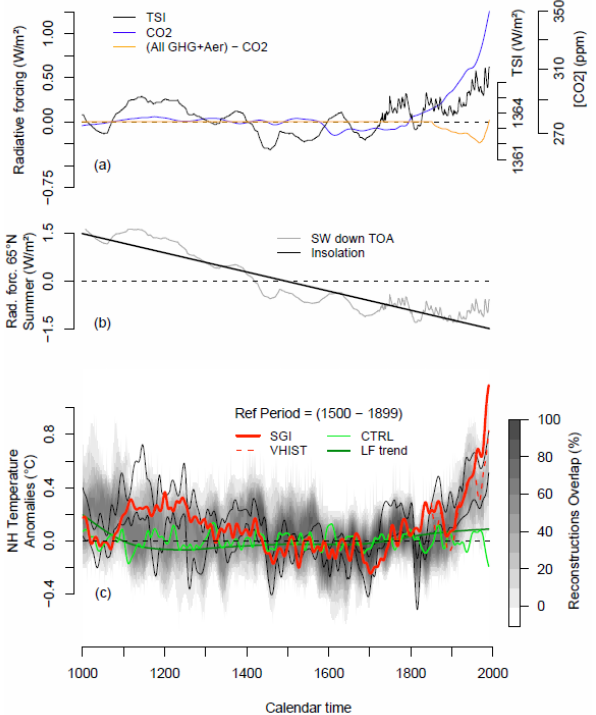
Figure 2 : Comparisons between thee recent reconstructions of the Northern Hemisphere surface temperature with SGI (red lines), on the 1000-1850 AD period. The upper panel (a) shows the reconstruction provided by (Mann et al., 2008) (blue lines), using both land and ocean data with the EIV method. On panel (b) the green lines correspond to the reconstruction of (Moberg et al., 2005), and the lower panel (c) shows the reconstruction of (Ammann and Wahl, 2007) (blue grey lines). The thin lines are the 10yr-running mean time series, sampled every ten years, and the thick lines are the cubic spline equivalent in number of degrees of freedom to a 50yr-running mean. The anomalies are calculated relative to the 1000-1850 period.